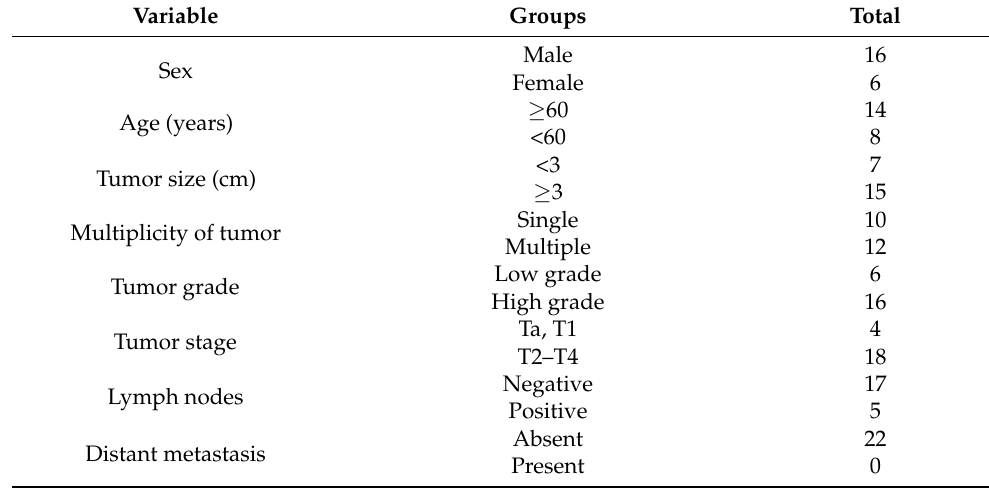
Table 4. Clinicopathological characteristics of 22 patients with